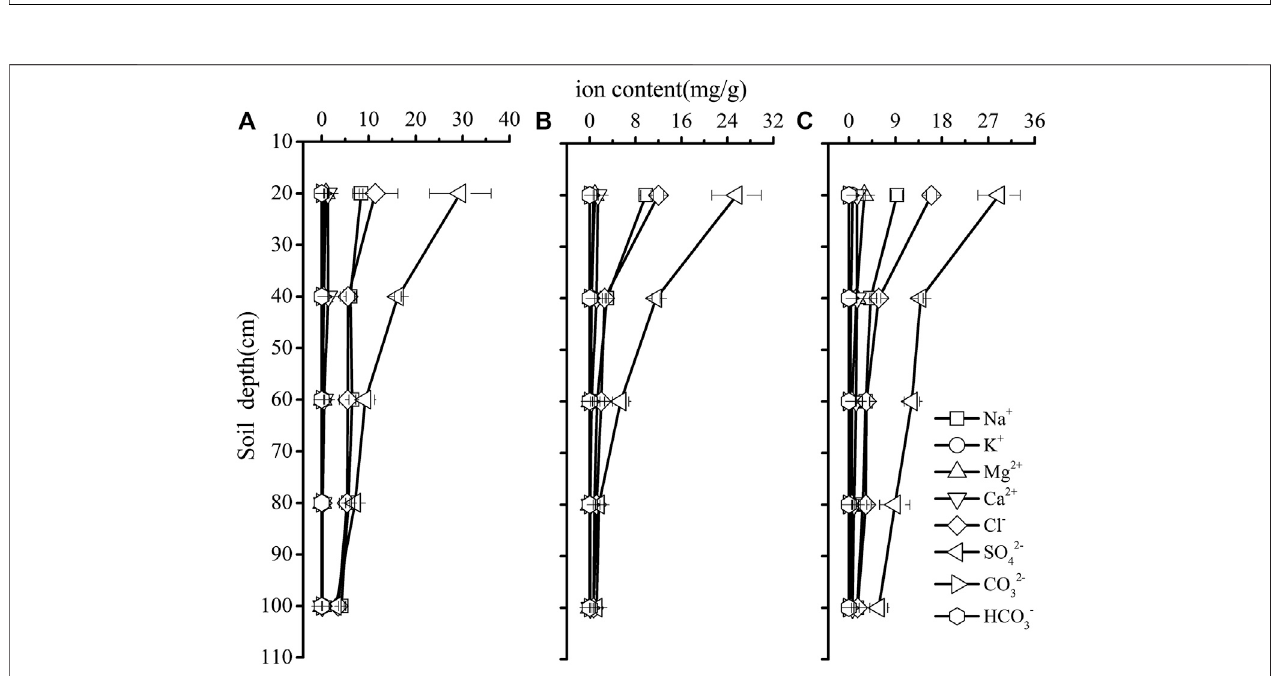
FIGURE 2 | Soil salinity distribution in the saline site 1 (A) , saline site 2 (B) and saline site 3 (C) . Data are presented as mean ± 1 SE.